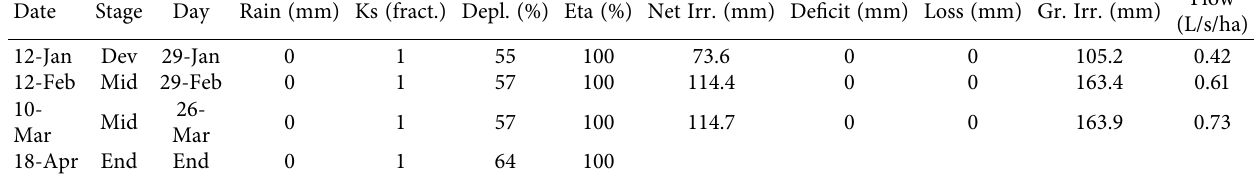
Table 15: Maize irrigation schedules.